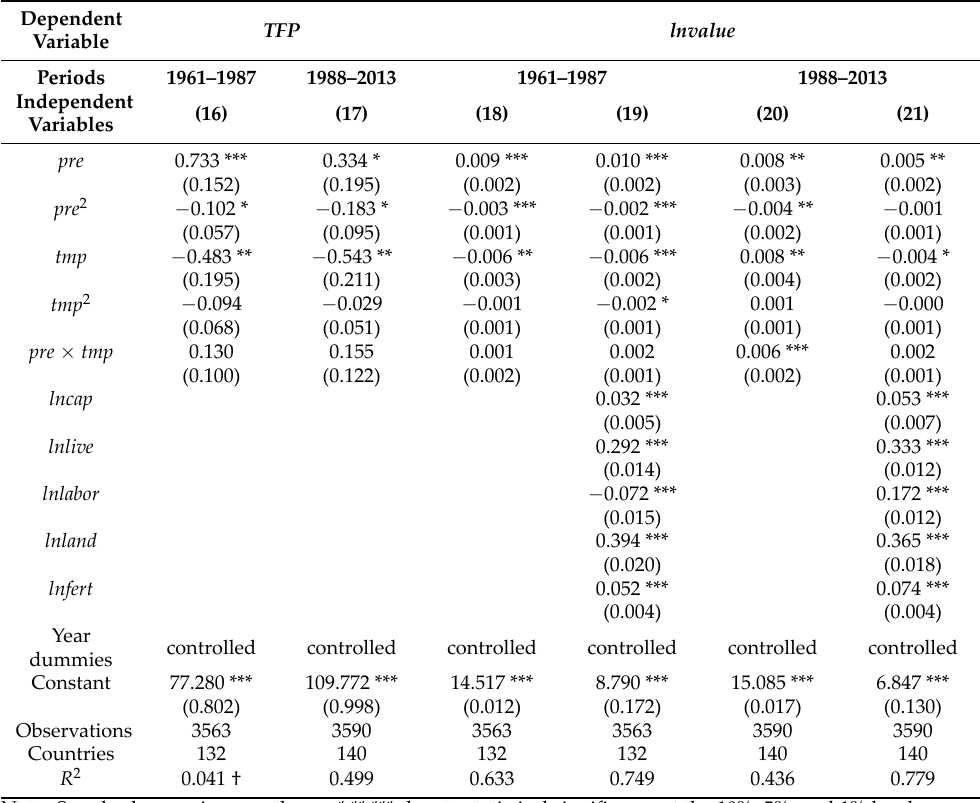
Table 7. Impact of climate change in different